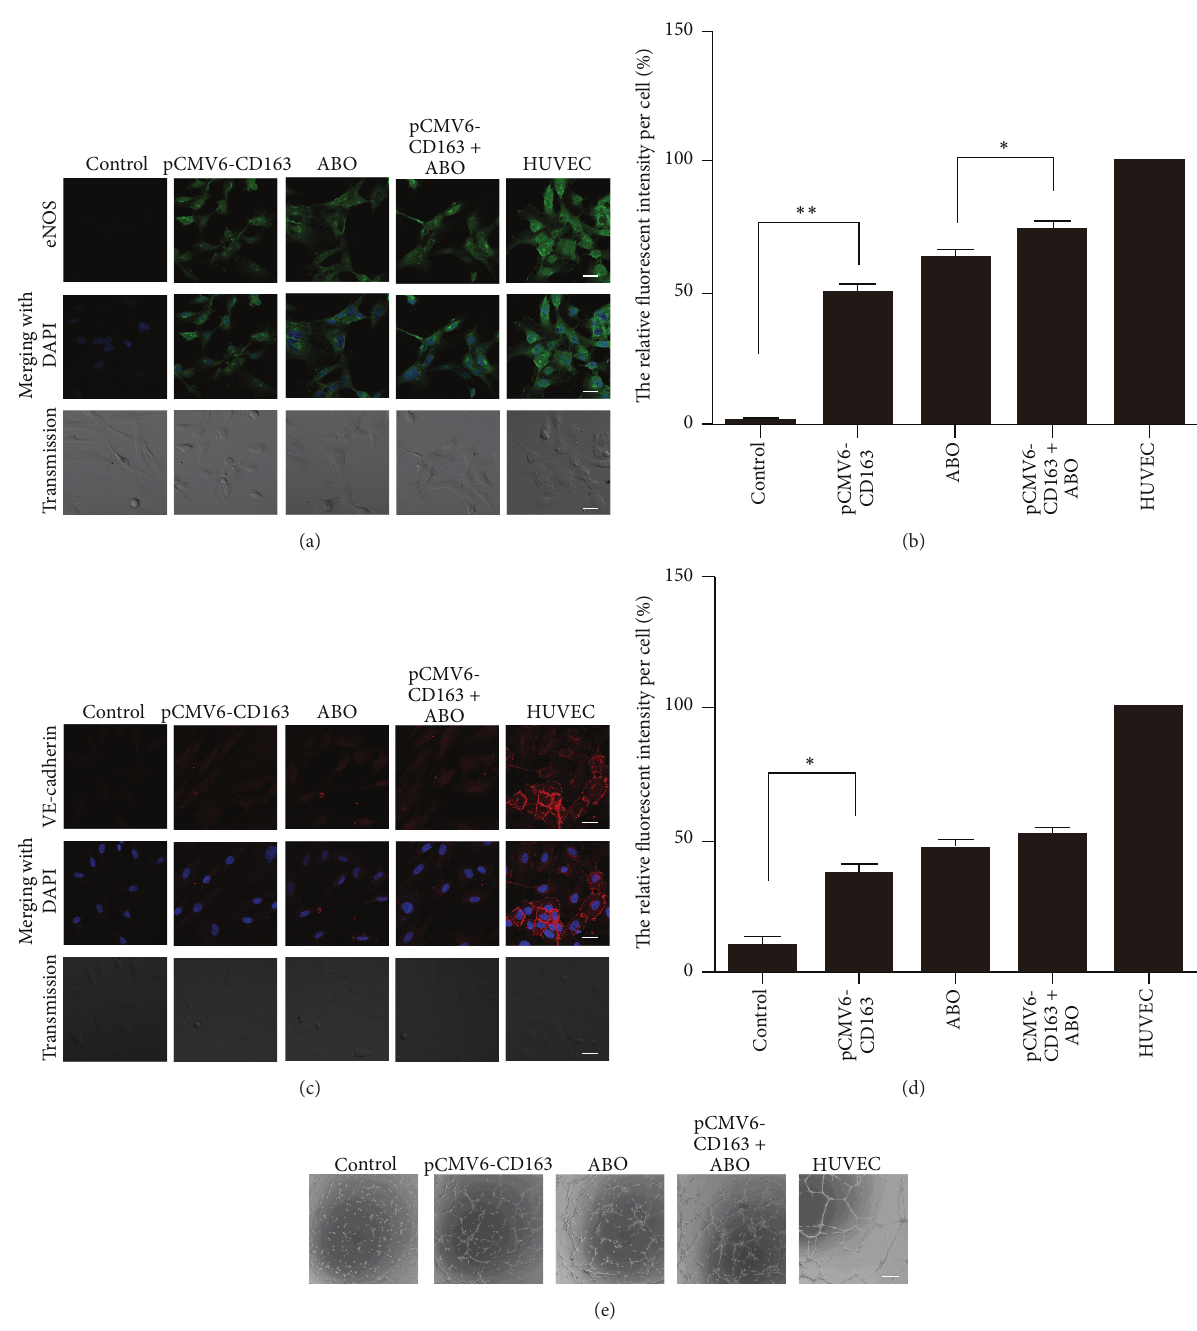
Figure 2: CD163 overexpression promoted BMSC differentiation into vascular endothelial-like cells with or without ABO treatment. In control group, BMSCs were transfected with empty vector pCMV6 and treated with 0.05% DMSO for 48h; in pCMV6-CD163 group, BMSCs were transfected with pCMV6-CD163 for 48 h; in ABO group, BMSCs were treated with 50 𝜇 M ABO for 48 h (DMSO as control); in pCMV6- CD163 + ABO group, BMSCs were transfected with pCMV6-CD163 and treated with 50 𝜇 M ABO for 48h; and in HUVEC group, human umbilical vascular endothelial cells are considered as a positive control. (a) Immunostaining of the endothelial-function associated marker endothelial nitric oxide synthase (eNOS) in BMSCs treated as described above. Scale bar: 10 𝜇 m. (b) The relative fluorescent intensity was calculated and the fluorescent intensity of HUVECs was set as 100%. (c) Immunostaining of the endothelial-specific marker VE-cadherin in BMSCs treated as described above. Scale bar: 10 𝜇 m. (d) The relative fluorescent intensity was calculated and the fluorescent intensity of HUVECs was set as 100%. (e) The vascular structure formed on Matrigel by BMSCs treated as described above. Scale bar: 100 𝜇 m. Images are representatives of at least 3 independent experiments. Data are mean ± SEM. ∗ 𝑝 < 0.05 , ∗∗ 𝑝 < 0.01 , 𝑛 ≥ 3